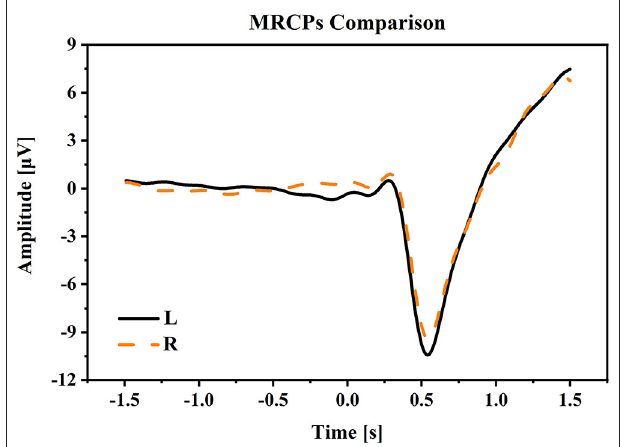
FIGURE 6 | Averaged EEG potential topographic maps of hand movement across all subjects. Note that time 0s is the Go-Cue, which indicates the movement execution, and time 0.5s is the actual movement